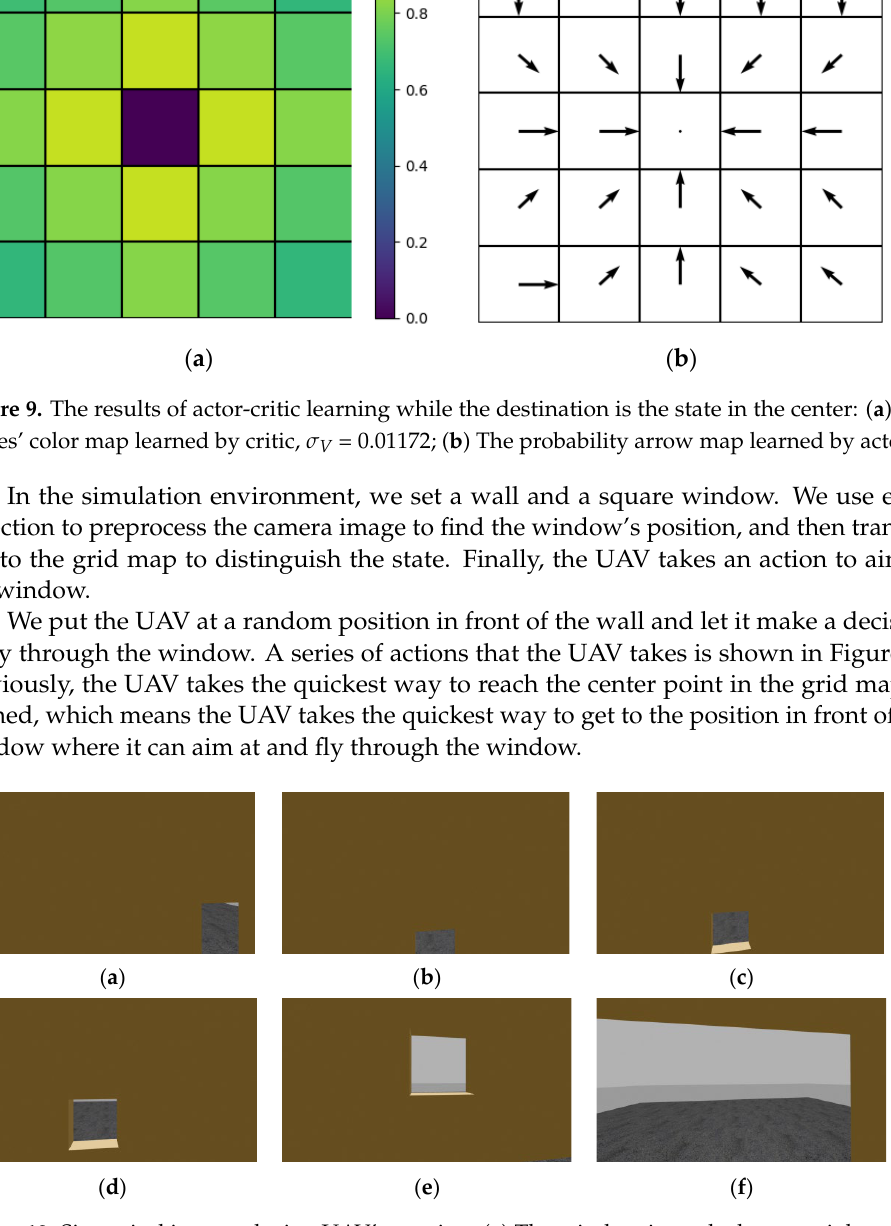
Figure 10. Six typical images during UAV’s moving: ( a ) The window is on the bottom-right corner and the state is on the up-left corner of the grid map, so the UAV moves right; ( b ) The UAV moves right; ( c ) The UAV moves up; ( d ) The UAV moves up; ( e ) The UAV is aiming at the window and it moves forward; ( f ) The UAV keeps moving forward and flies through the window.